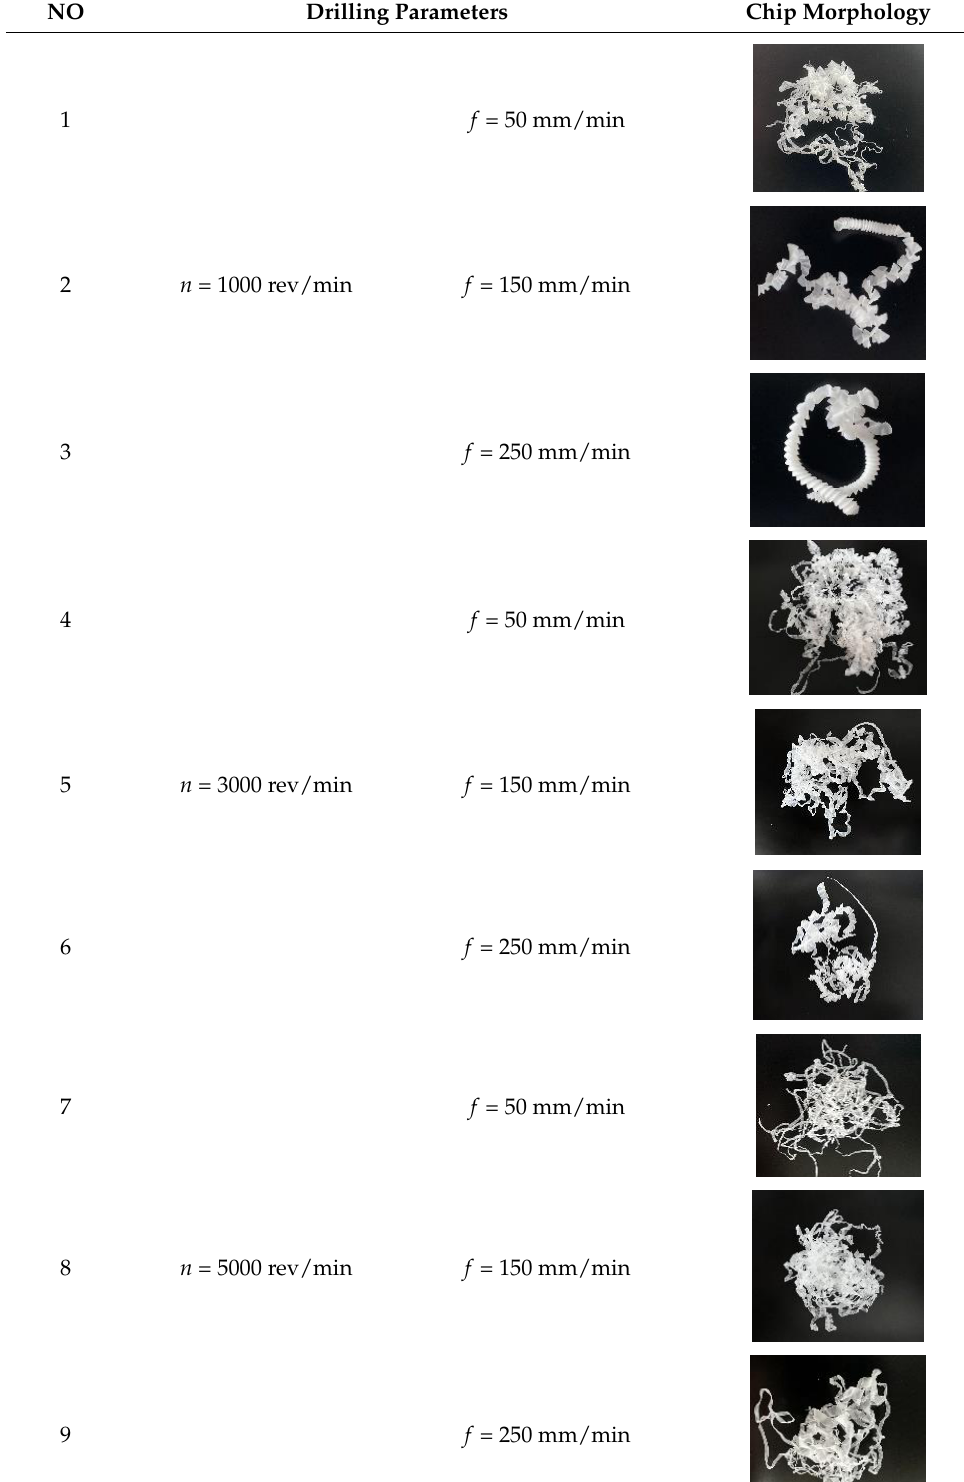
Table 4. Chip morphology under different machining parameters.